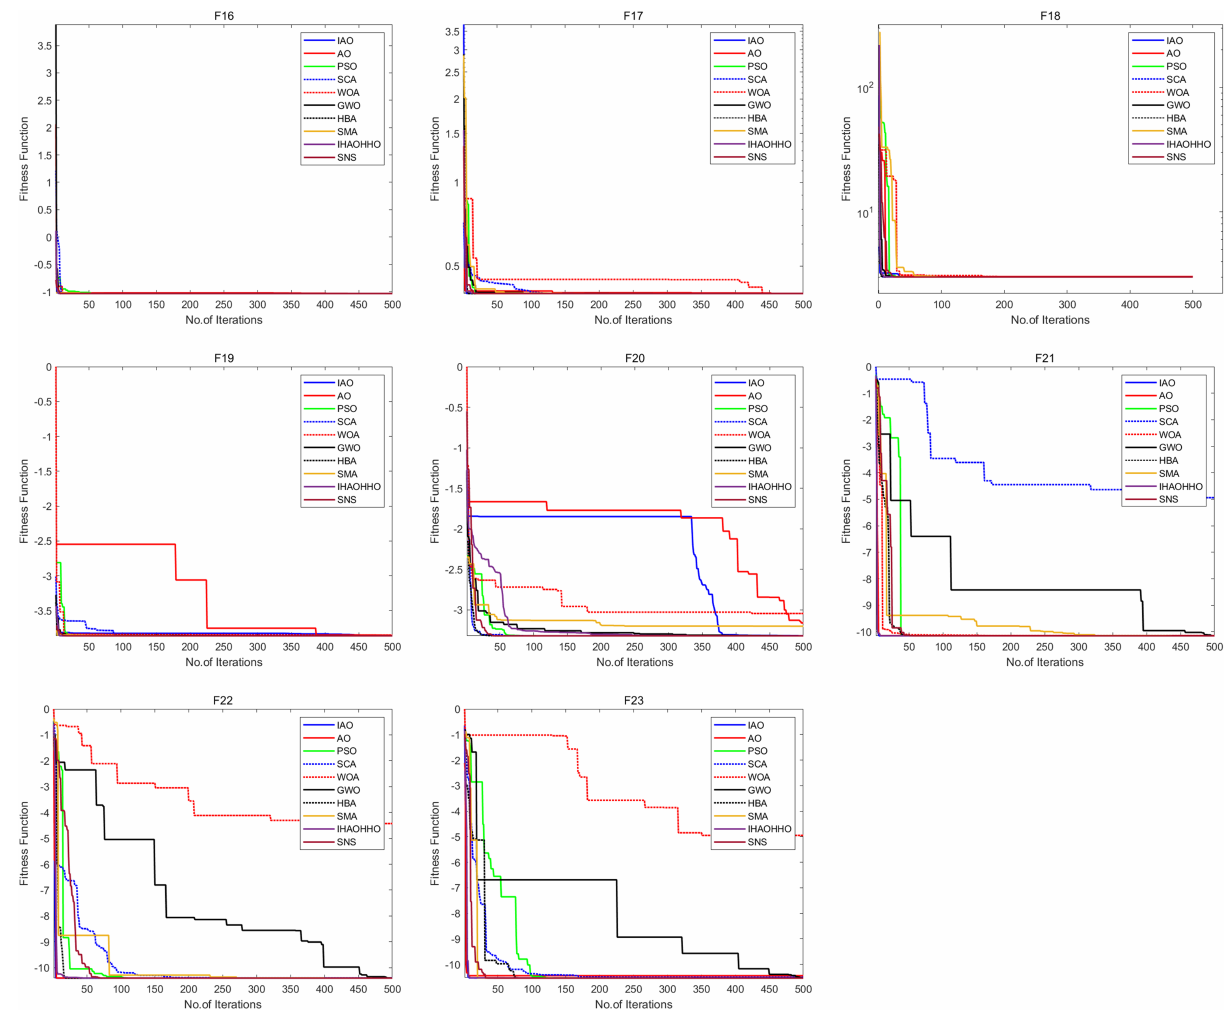
Figure 5. Qualitative results of